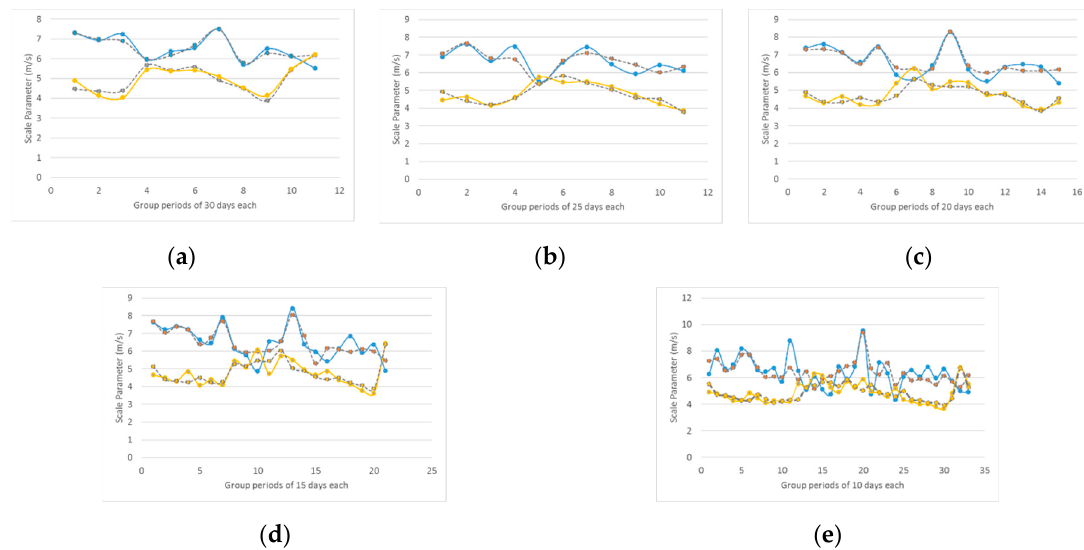
Figure 13. Predicted scale parameters at different horizons. The blue and the gray dashed lines correspond to the values of the measured and predicted values of the scale parameter in the WS season. The yellow and the gray dashed lines correspond to the values of the measured and predicted values of the scale parameter in the SF season. The horizons of the prediction are as follows: ( a ) 30 days ahead; ( b ) 25 days ahead; ( c ) 20 days ahead; ( d ) 15 days ahead; and ( e ) 10 days ahead.